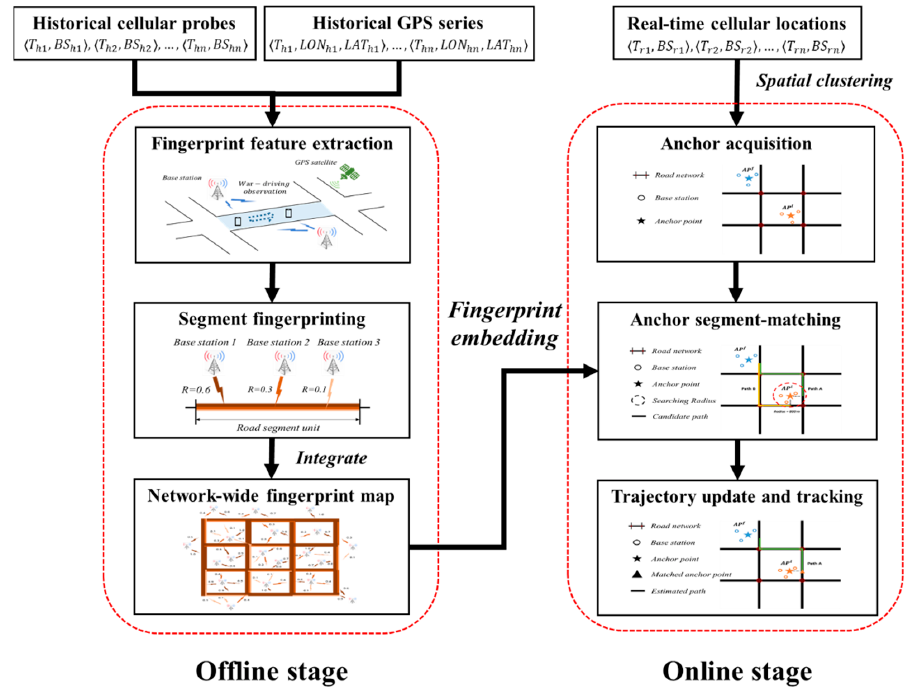
Figure 3. The two-stage trajectory estimation framework based on cellular signaling data.